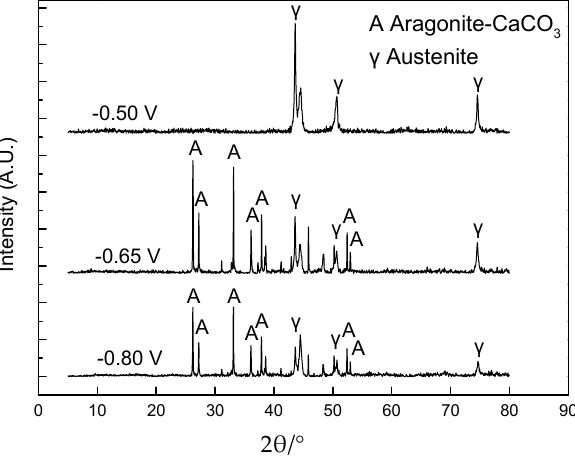
Figure 11. XRD patterns of 304 SS after cathodic polarization for 168 h in sea water at different potentials.